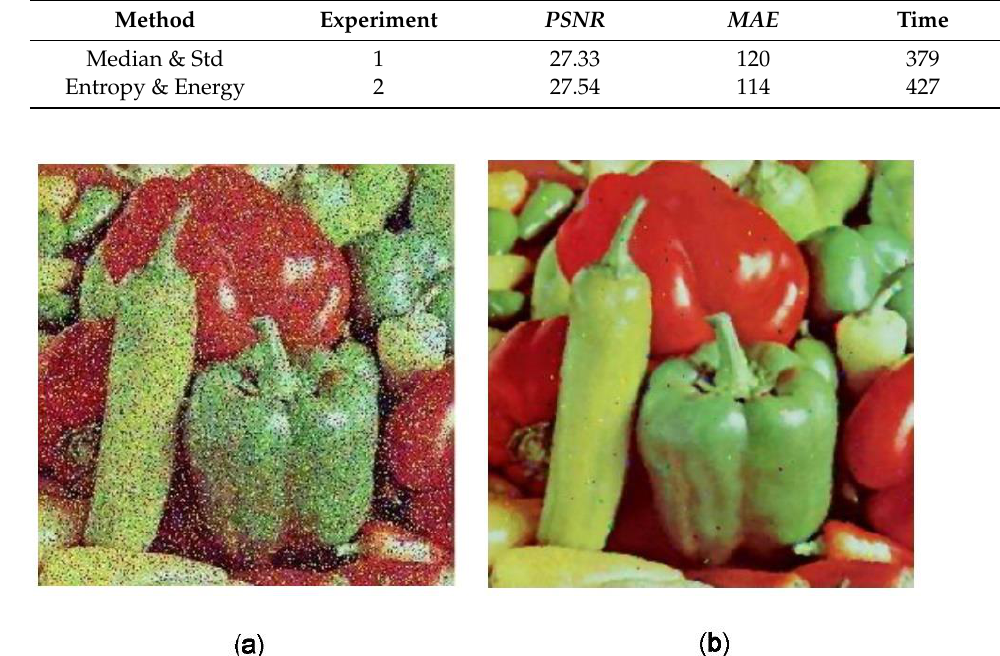
Figure 5. Impulsive noise-restored images with 20% density Using the TASOM classifier in the color form with the median filter: ( a ) Noisy Image and ( b ) Restored Image.